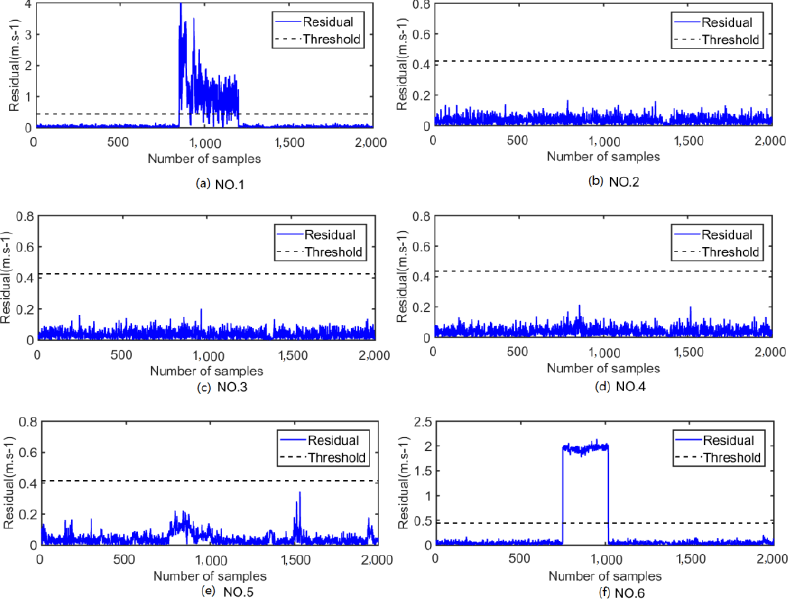
Figure 7. Multiple fault status of the six anemometers: ( a ) Residual curve of WTG 1; ( b ) Residual curve of WTG 2 ( c ) Residual curve of WTG 3 ( d ) Residual curve of WTG 4 ( e ) Residual curve of WTG 5 ( f ) Residual curve of WTG 6